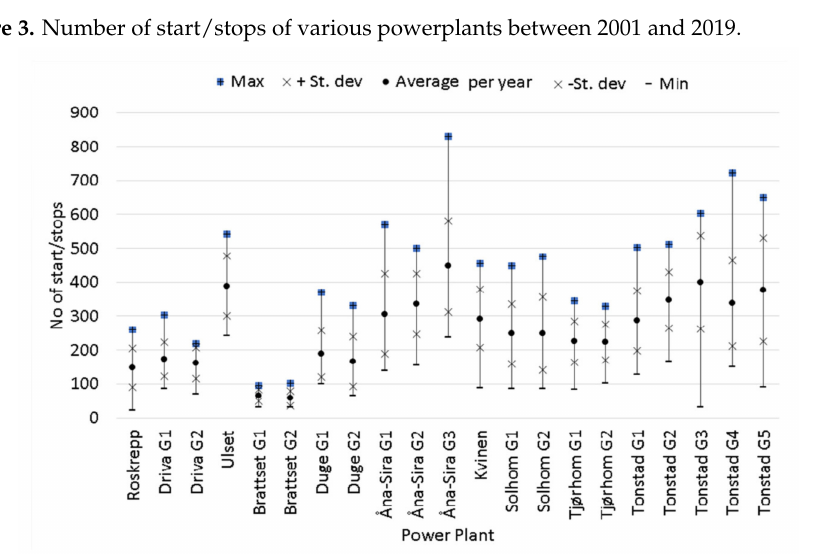
Figure 4. Statistical values of start/stops for various power